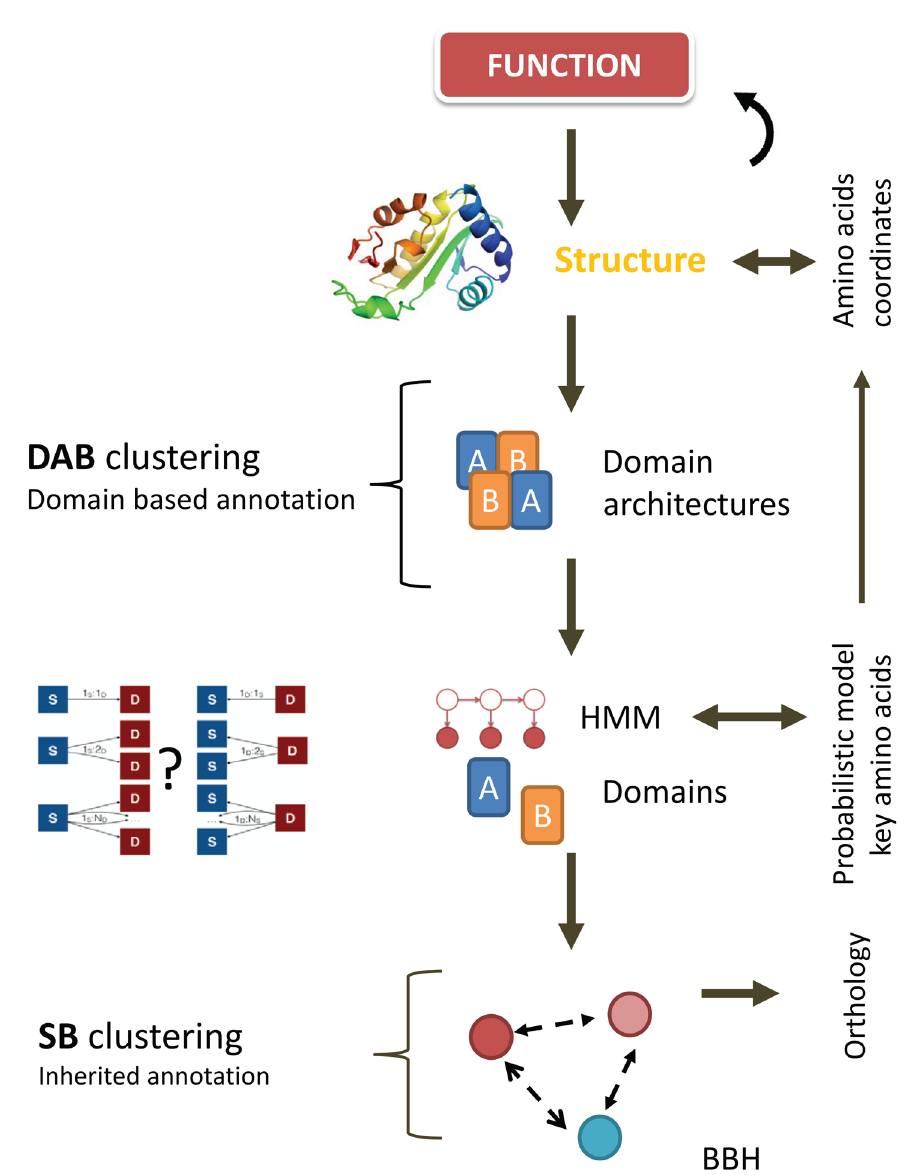
Figure 2. Relationship between Domain Architecture Based (DAB) and Sequence Similarity based (SB) clustering with respect to functional annotation. Domains are probabilistic models of amino acids coordinates obtained by hidden Markov modeling (HMM) built from (structure based) multiple sequence alignments. Domain architectures are linear combinations of these domains representing the functional potential of a given protein sequence and constitute the input for DAB clustering. SB-orthology clusters inherit functional annotations via best bi-directional hits above a predefined sequence similarity cut-off